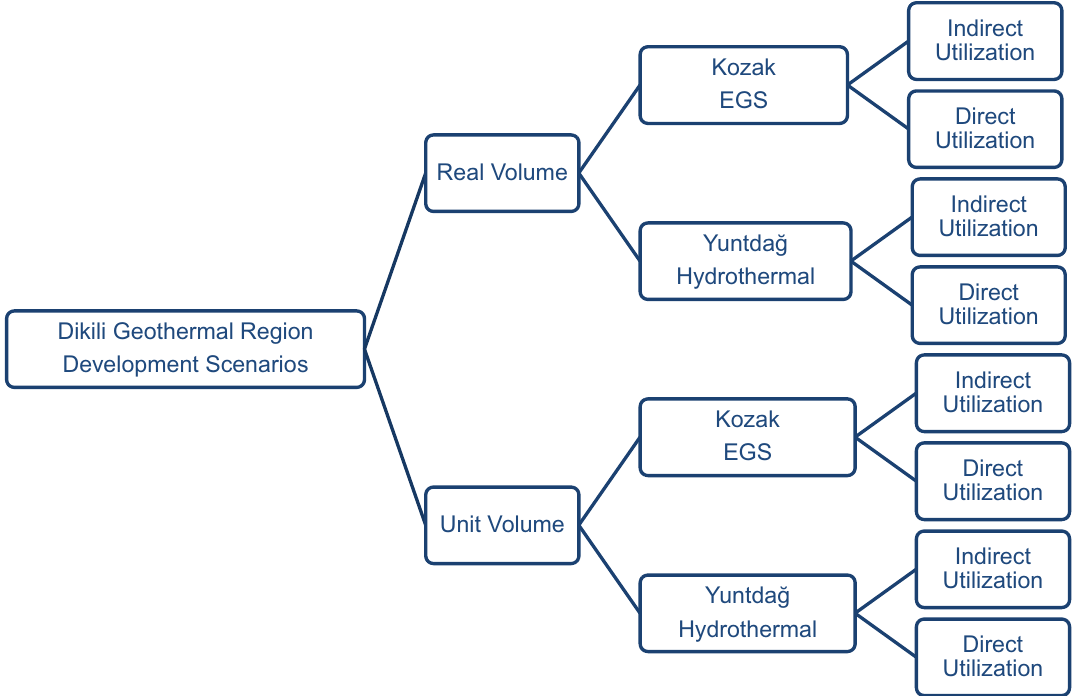
Fig. 6 Development scenarios with different utilization ways of Yuntdağ and Kozak reservoirs. Both real and unit volumes are